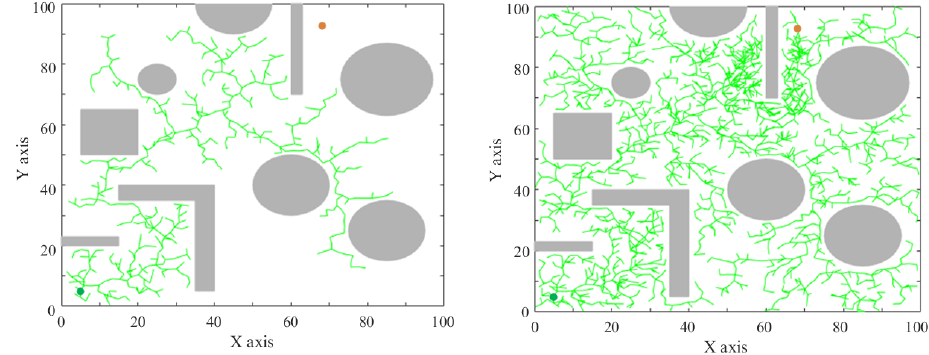
Figure 6. Tree expansion using dynamic area sampling (( Left ) sampling time = 500, α = 0.5, collision detection times = 1647; ( Right ) sampling time = 2000, α = 0.8, and collision detection times =